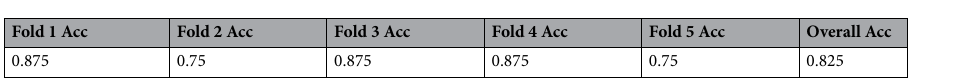
Table 6. Performance measures of the constructed random forest model with fivefold cv. *Accuracy: Acc.